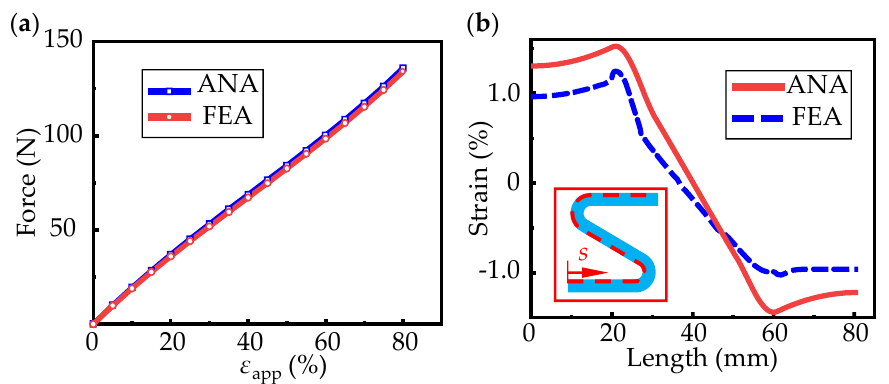
Figure 4. The comparisons between analytical and FEA results. ( a ) The variation of force with ap-plied strain; ( b ) the variation of strain along the path showed inside of figure.